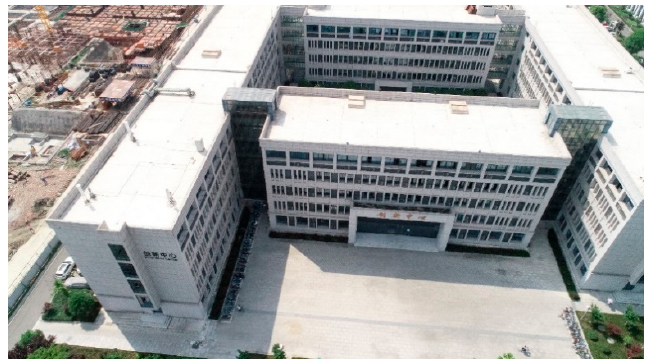
Figure 21. Innovation Center Building of Qingshuihe Campus, UESTC, from the perspective of UAV.